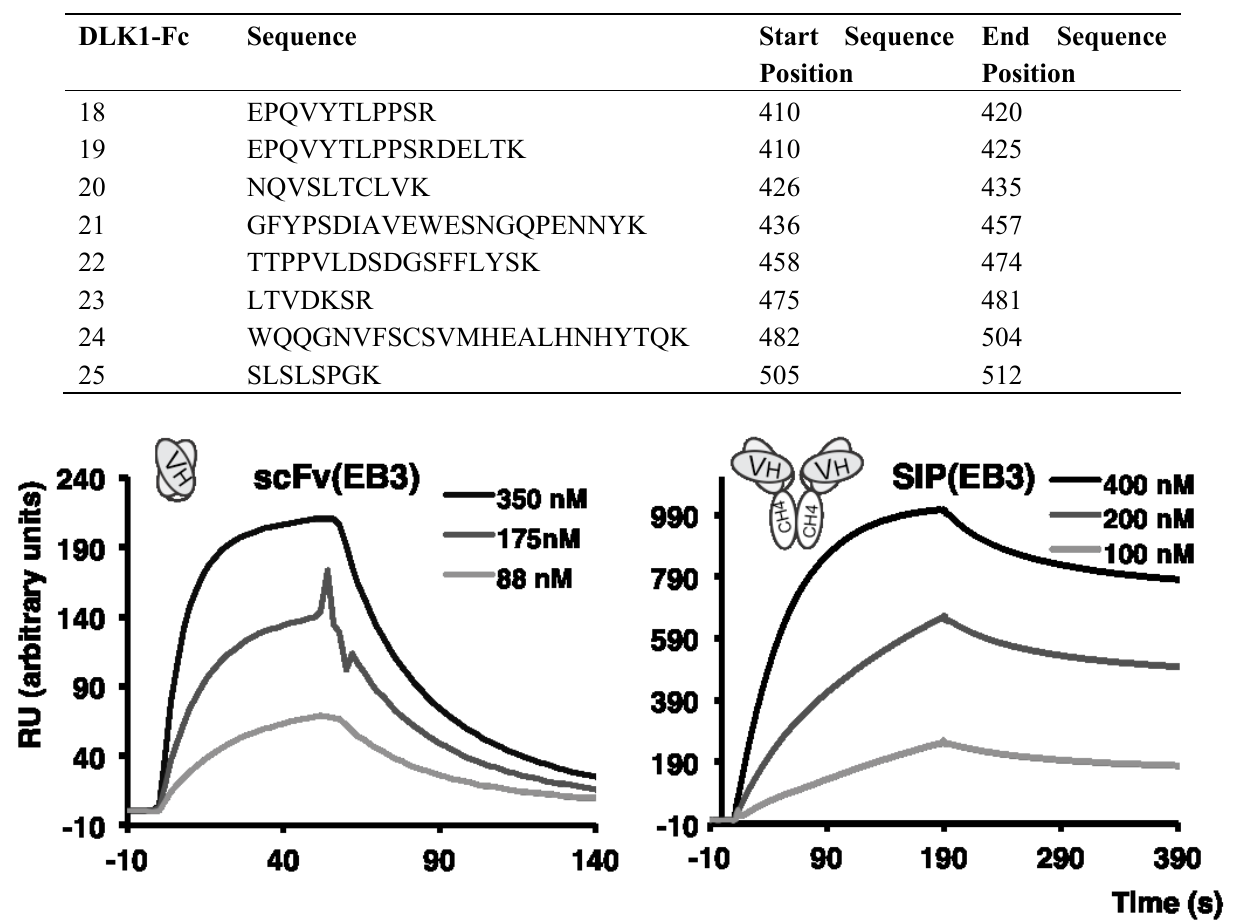
Figure 2. BIAcore profiles of the anti-DLK1 scFv antibody (left) and the SIP antibody (right) against human recombinant DLK1-Fc fusion